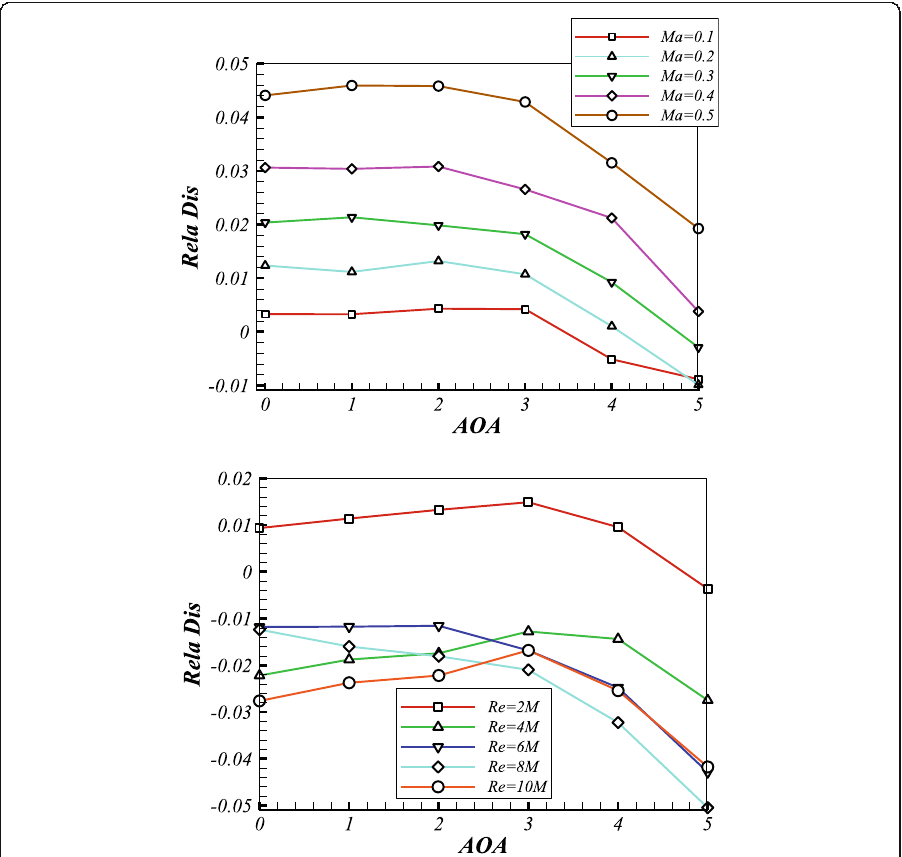
Fig. 14 The relative error of C d of the test cases, where Rela Dis = ( C d , ML − C d , SA )/ C d , SA